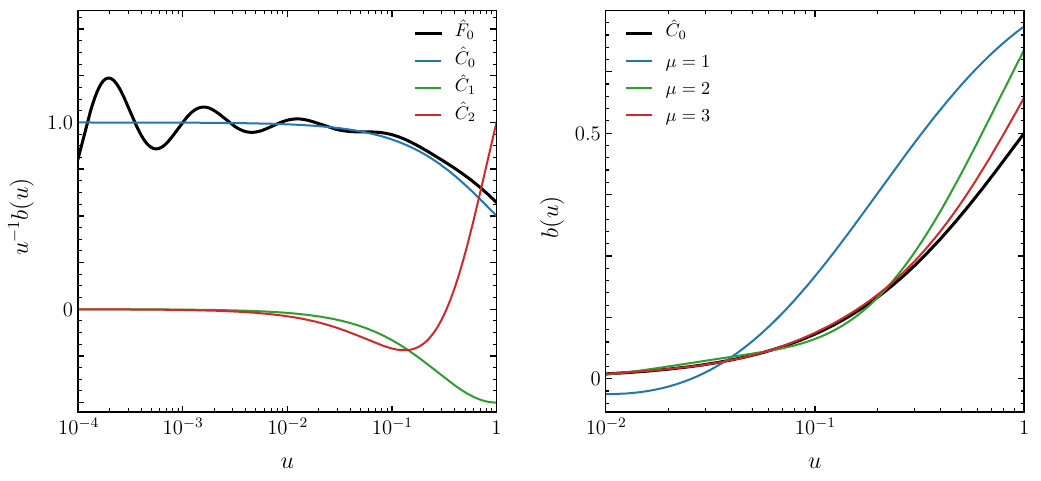
Figure 12. Left panel: comparison of the source functions b ( u ) as a function of u between the scalar exchange solution ( (cid:22) 2 + 1 ) ^ F 0 for (cid:22) = 3 and the contact terms ^ C n for n = 0 ; 1 ; 2. Right panel: 4 comparison between the leading contact term ^ C 0 and ( (cid:22) 2 + 1 ) ^ F 0 for (cid:22) = 1 ; 2 ; 4